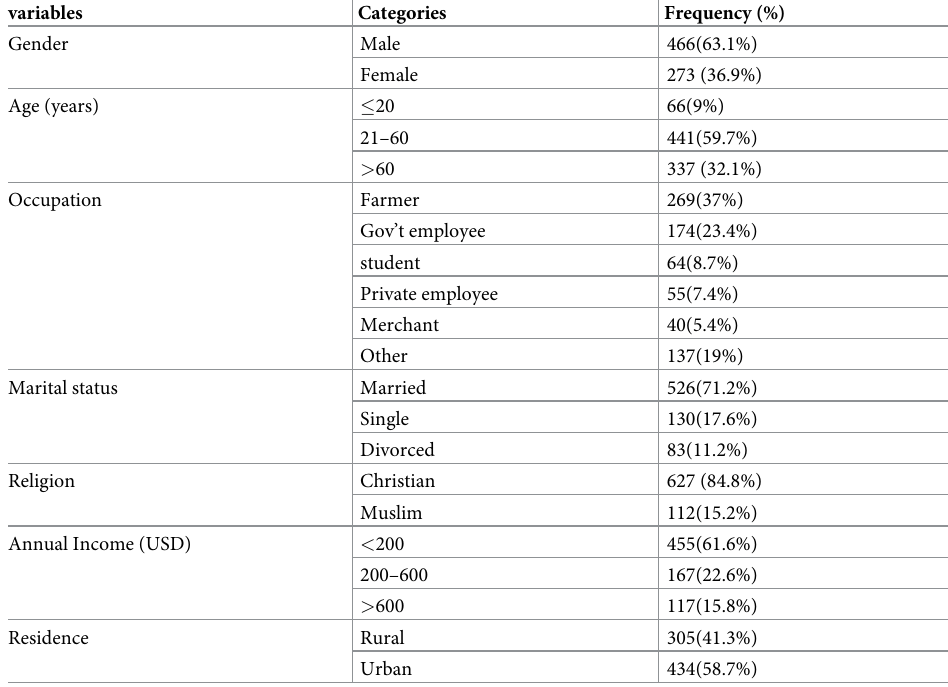
Table 1. Socio-demographic characteristics of patients with vitreo-retinal diseases presented to the University of Gondar Tertiary eye care and training center vitreoretina clinic, NW Ethiopia (n =